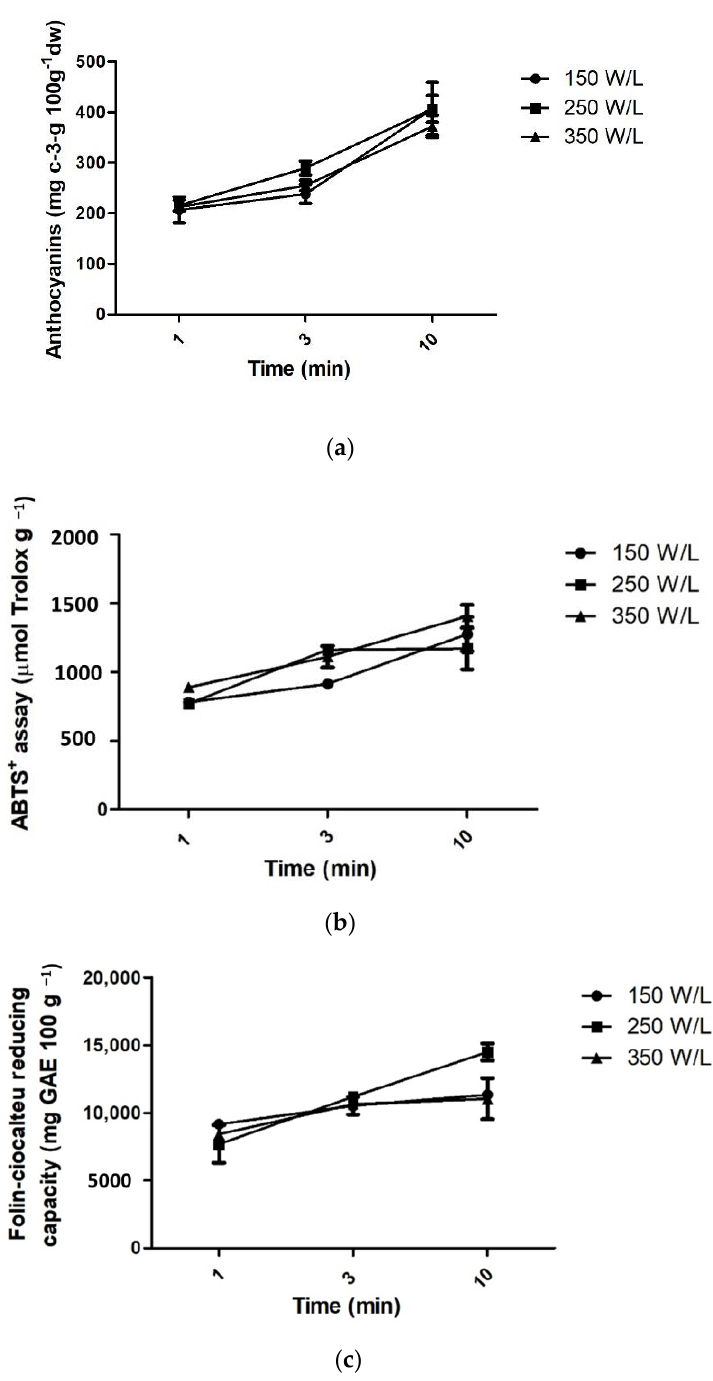
Figure 4. Total monomeric anthocyanins content ( a ), ABTS+ ( b ), and Folin – Ciocalteu reducing capacity ( c ) of jaboticaba skin extracted by UAE.